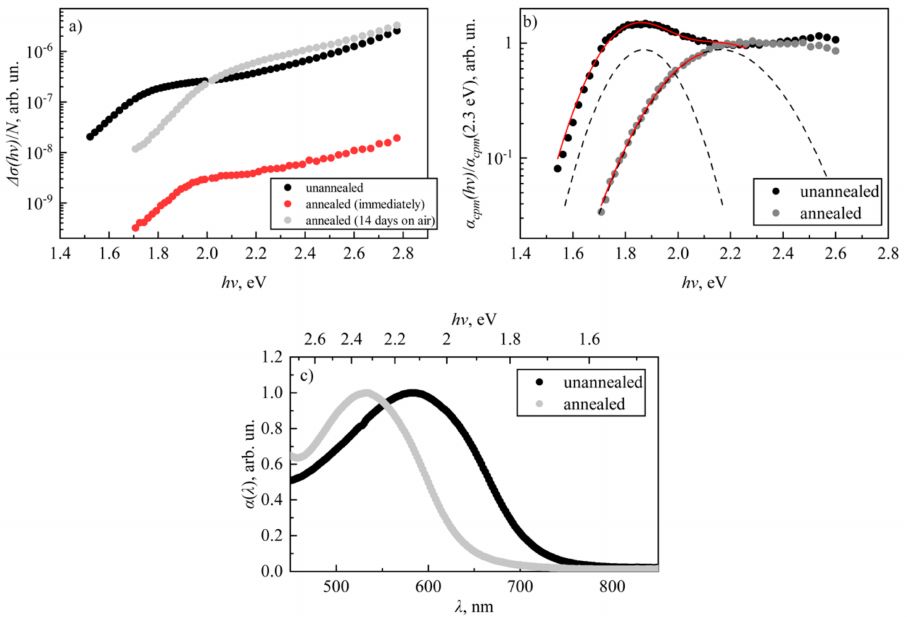
Figure 3. Spectral dependences of ( a ) photoconductivity ∆ σ , normalized to the number of incident photons N , ( b ) the absorption coe ffi cient α cpm , normalized to its value at h ν = 2.3 eV, and ( c ) UV-Vis absorption